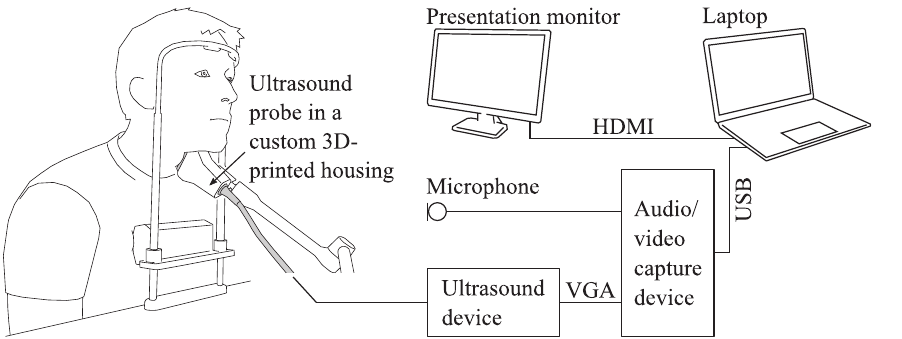
Fig 1. Measurement setup. The subject uttered the sequences that were displayed on the presentation monitor. A frame that served as a rest for the forehead and for the sternum helped the subject maintaining a constant position throughout the experiment. The subject’s vertical larynx movements were recorded by means of laryngeal ultrasound. The resulting ultrasound video was stored on a laptop together with time-synchronous audio.